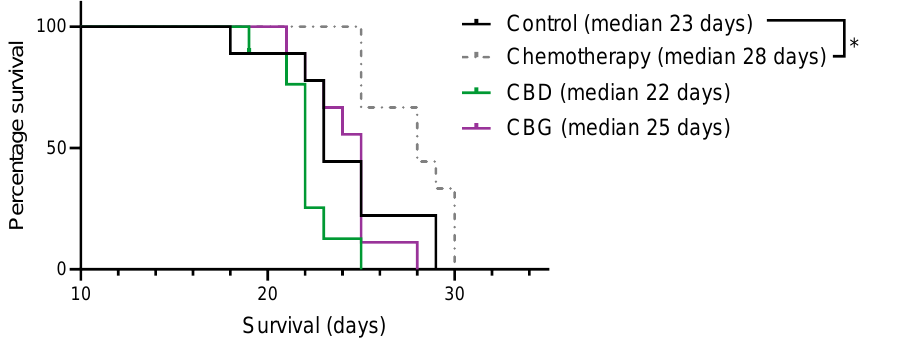
Figure 7. Pemetrexed + cisplatin but not cannabidiol (CBD) or cannabigerol (CBG) treatment pro- longs survival in a rat syngeneic orthotopic model of pleural mesothelioma. Rats were pleurally engrafted with mesothelioma cells and then treated with control (vehicle), cisplatin + pemetrexed (chemotherapy), 40 mg/kg CBD or 100 mg/kg CBG for 4 weeks and overall survival was assessed. Data were analysed using Log-rank (Mantel-Cox) test. * p < 0.05 versus vehicle control.